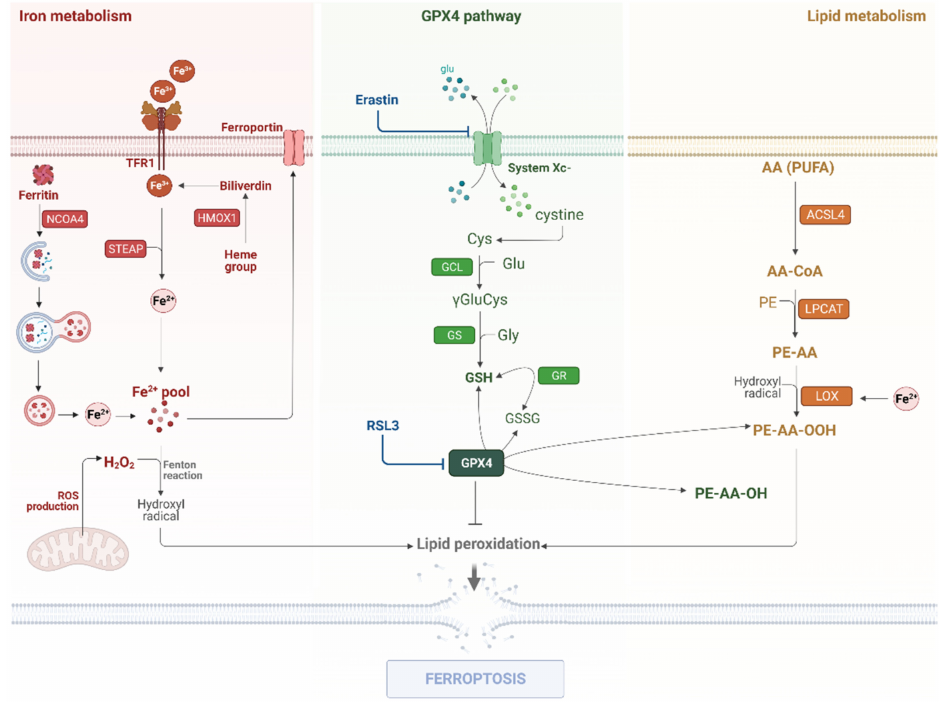
Figure 1. The molecular mechanisms of the ferroptosis pathway. Ferroptosis is triggered by three main regulatory pathways: iron metabolism, the GPX4 pathway, and lipid metabolism. In the iron metabolism, Fe 3+ (ferric iron) is transported into the cell by TfR1 (Transferrin receptor) or obtained through the conversion of the heme group to biliverdin by HMOX1 activity. Then, Fe 3+ is reduced to Fe 2+ (ferrous iron) by STEAP3. Ferritin degradation by NCOA4 via autophagy also contributes to the labile iron pool. Once in the cytosol, Fe 2+ can react with ROS and it generates the hydroxyl radical, promoting PUFA oxidation. The GPX4 pathway is responsible for controlling the lipoperoxidation levels through the reduction of lipid peroxides (PE-AA-OOH) to lipid alcohol (PE-AA-OH), thus GPX4 blockage by RSL3 induces ferroptosis. GPX4 utilizes GSH as a cofactor, therefore the GSH synthesis pathway is directly related to GPX4 activity, and xCT system blockage by Erastin leads to ferroptotic cell death. In the lipid metabolism, AA (as well as other PUFAs) are metabolized by ACSL4 and esterified by LPCAT3. Then, LOXs oxidize PUFAs using Fe 2+ as a cofactor, which produces lipid peroxides. Created with